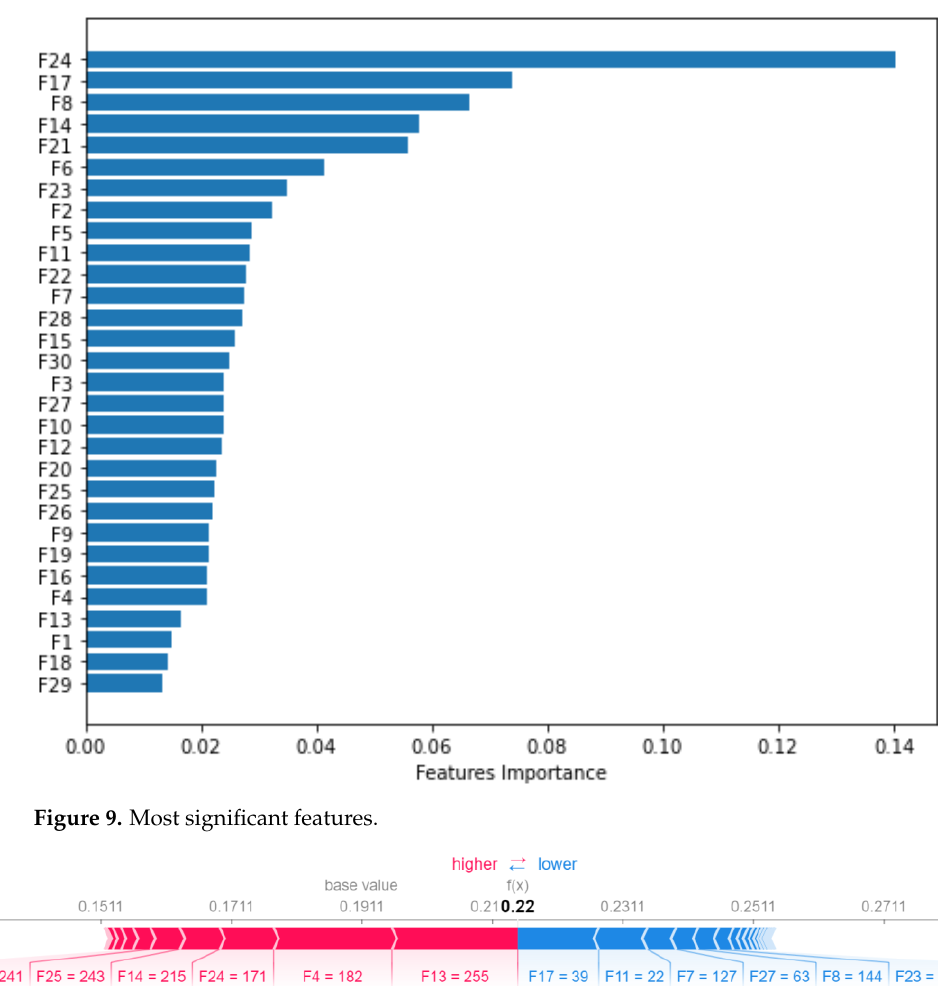
Figure 10. Contribution of features to a certain class based on a threshold value.